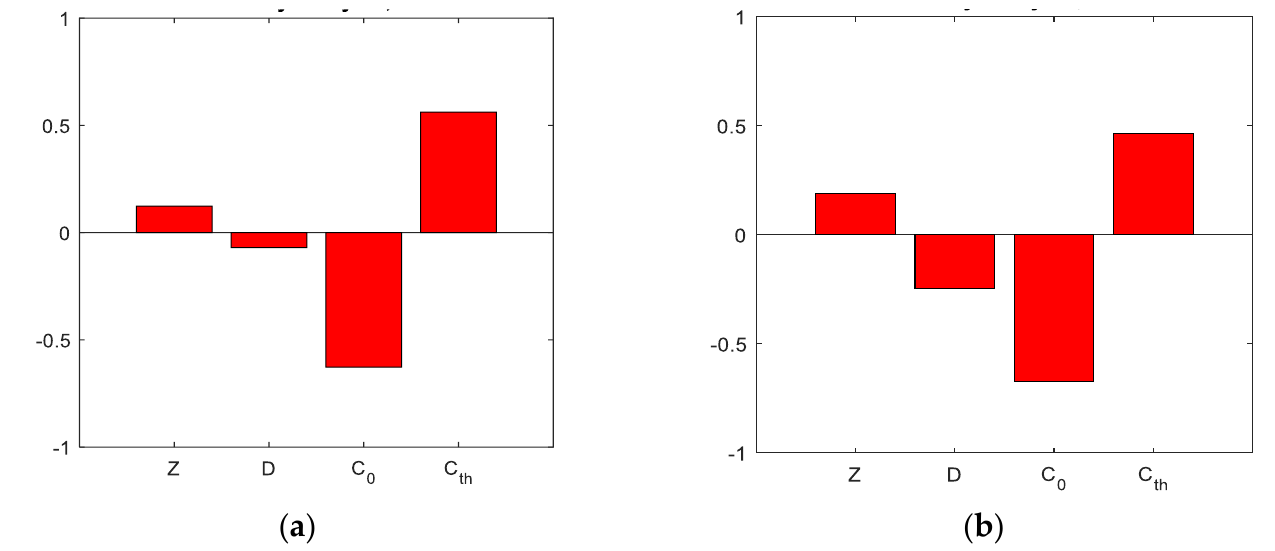
Figure 2. Correlation coefficients of the input parameters for all concretes: ( a ) OPC, ( b ) SCC 0%.